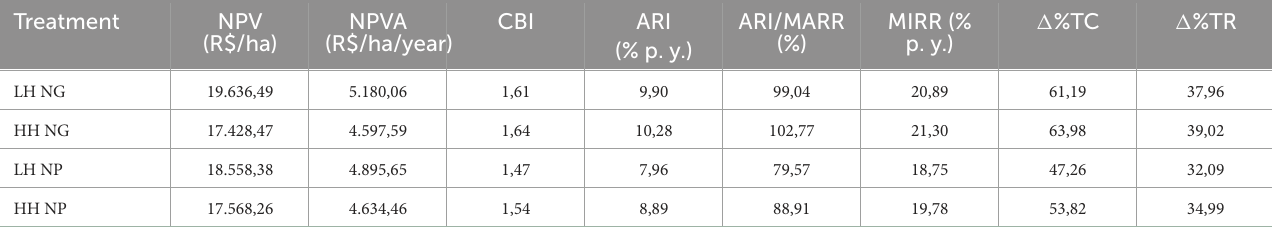
TABLE 6 Economic viability indicators for ICLS treatments for 5.5